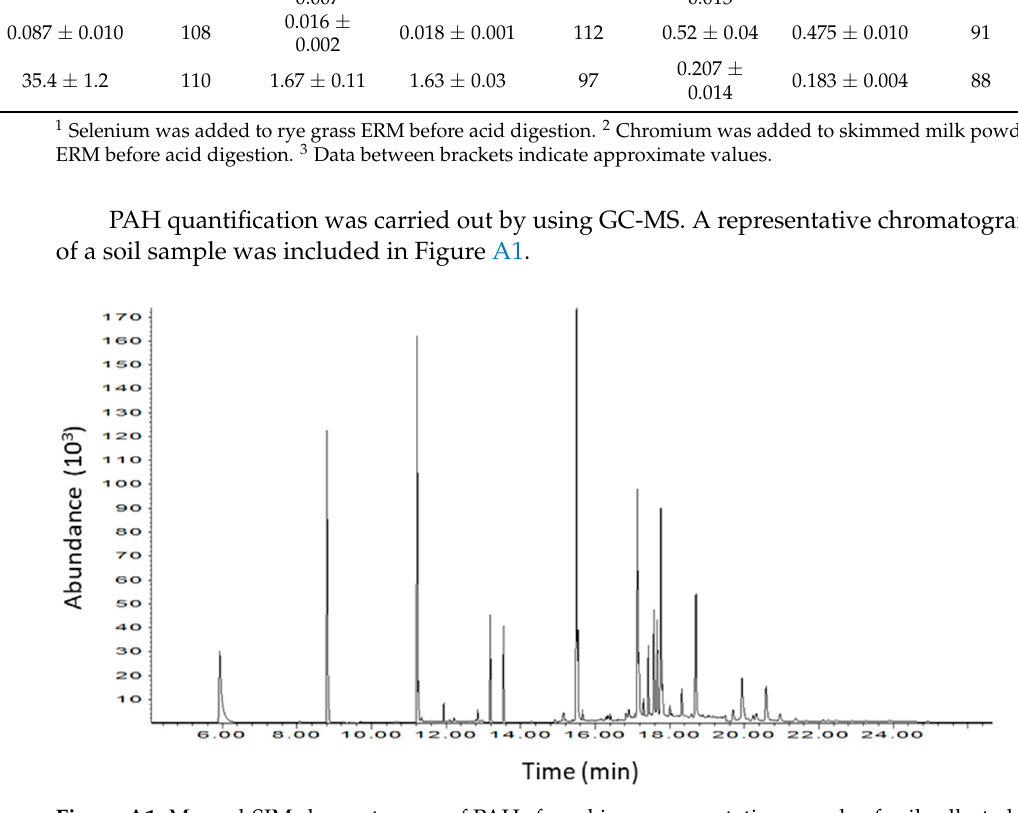
Figure A1. Merged-SIM chromatogram of PAHs found in a representative sample of soil collected in the vicinity of the industrial areas. Concentrations found in µg·kg − 1 (main peaks): naphthalene (1.04), acenaphthylene (0.71), acenaphtene (0.64), Fluorene (0.61), phenanthrene (9.73), anthracene (0.89), fluoroanthene (10.23), pyrene (7.98), benzo(a)anthracene (5.06), chrysene (7.06), benzo(k)fluoroanthene (14.68), benzo(b)fluoroanthene (3.43), benzo(a)pyrene (5.62), and benzo(g,h,i)perylene (5.44).